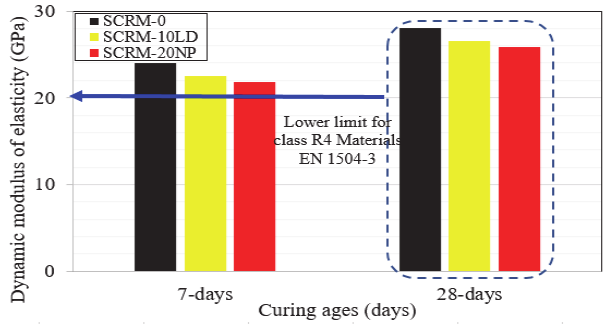
Figure 8: Variation of dynamic modulus of elasticity with age for